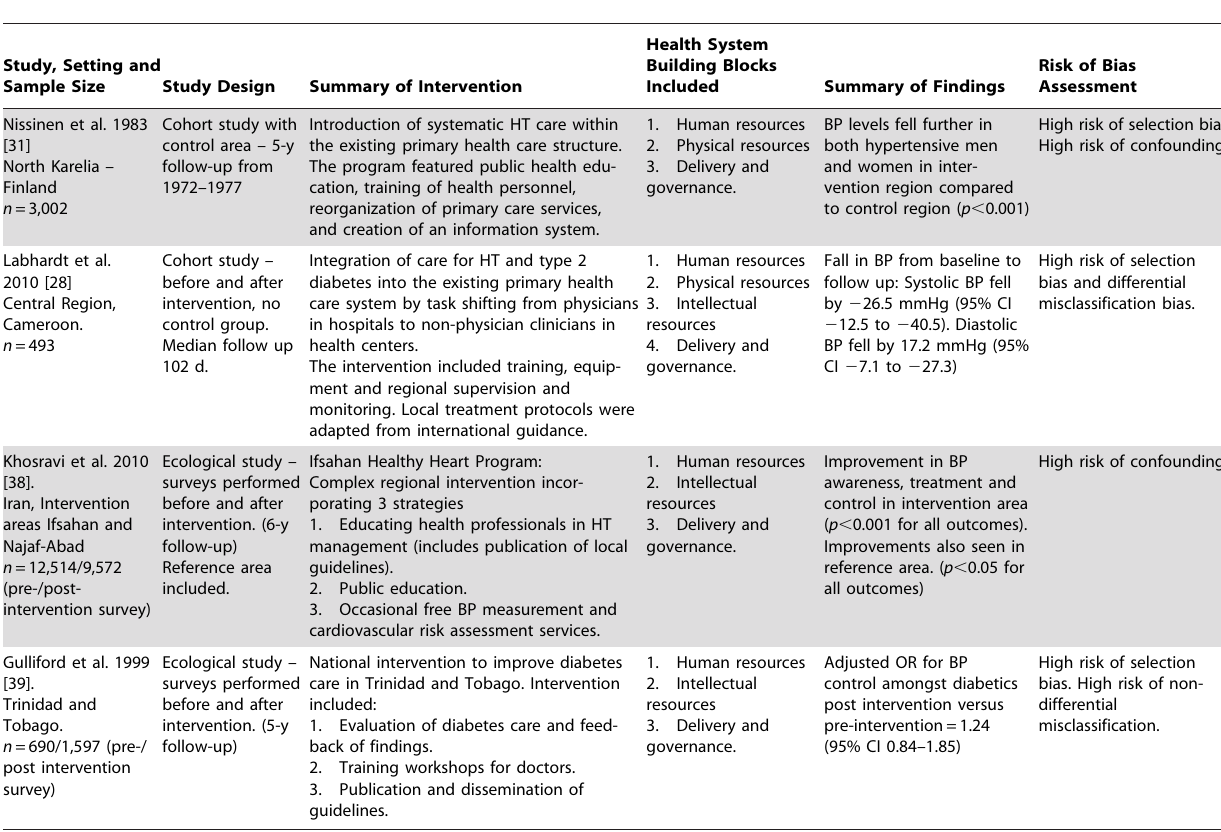
Table 7. Description and summary of findings of studies evaluating complex national or regional interventions incorporating components from more than one health system building